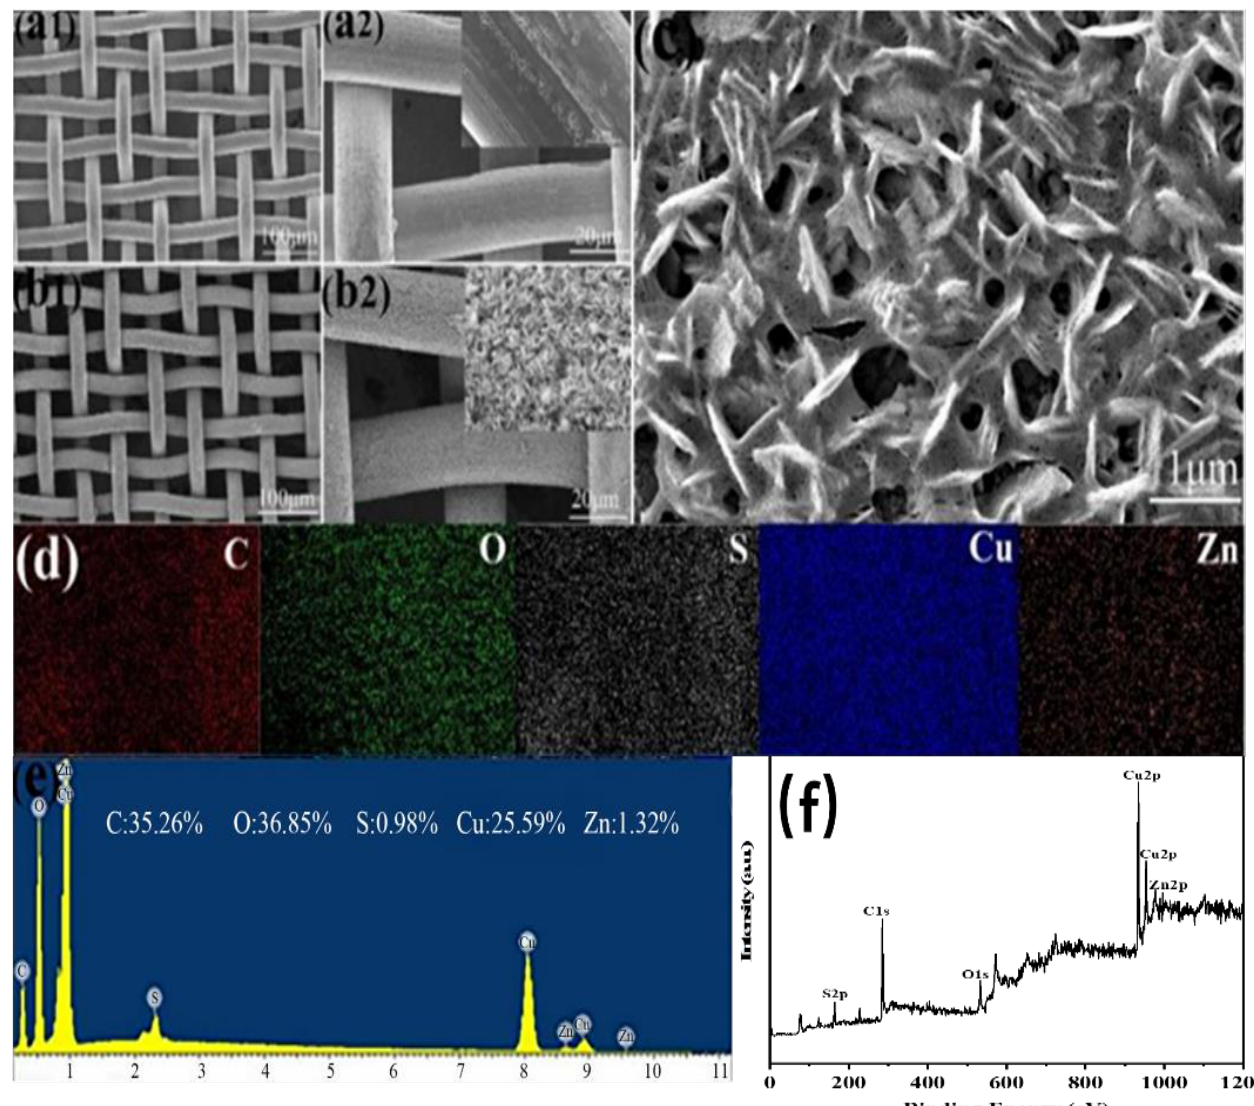
Figure 1. Characterization of the pristine, etched, and modified brass meshes by SEM, EDS, and XPS. ( a1 ) The morphology of the pristine brass mesh;( a2 ) The enlarged SEM images for the morphology of the pristine brass mesh; ( b1 ) The morphology of the chemically etched brass mesh; ( b2 ) The enlarged SEM images for the morphology of etched brass mesh; ( c )The morphology of the modified brass mesh with a thin SAM; ( d ) EDS mapping image of the modified brass mesh; ( e ) EDS analysis of the modified brass mesh;( f ) XPS spectrum of the modified brass mesh.